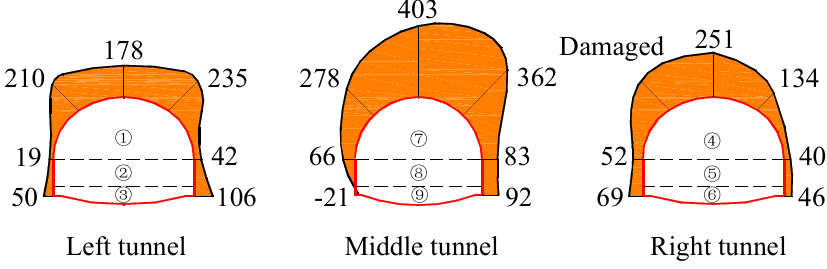
Figure 16. Distribution of surrounding rock pressure at section DK67 + 950 (Unit: kPa).